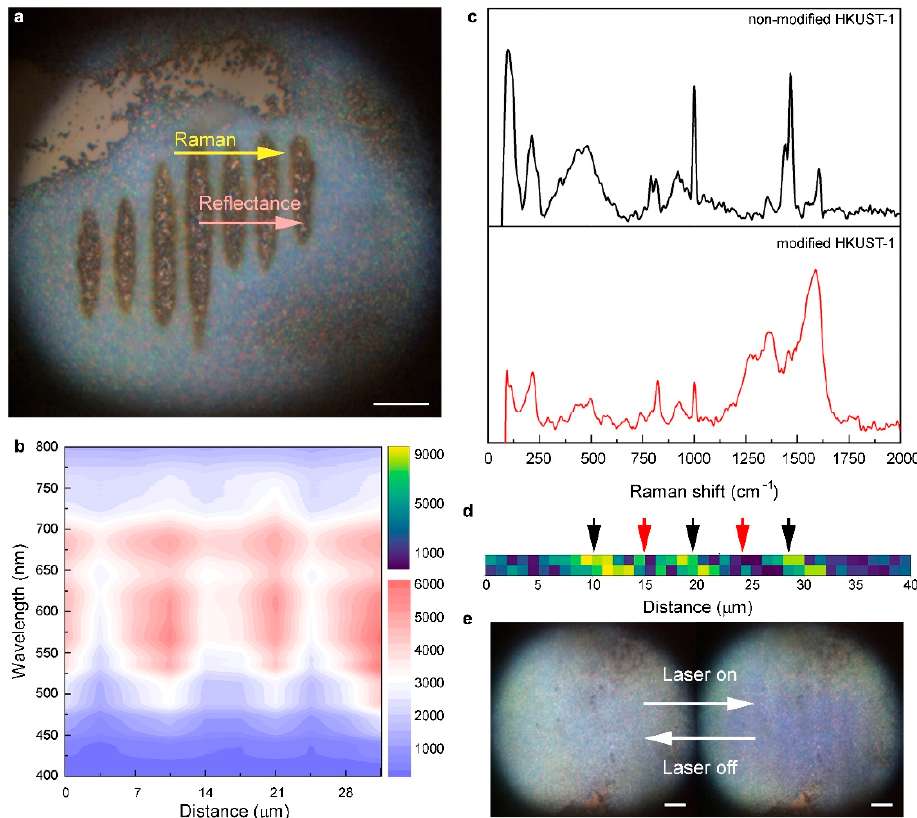
Figure 3. ( a ) Optical image of the irreversible pattern, analyzed by ( b ) optical reflection (pink arrow) and ( c , d ) Raman (yellow arrow) mapping. Scale bar for ( a ), 20 µm. ( c ) The laser interference minima and maxima corresponding to the non-modified area (black curve and black arrows in ( d )) and the modified area (red curve, red arrows in ( d )) of the HKUST-1 thin film. ( d ) Raman mapping of coordination-bonds (the vibrations of Cu-O of the [Cu 2 C 4 O 8 ] cage centered at 180–290 cm − 1 ); black arrows indicate the bond retention, while the red ones correspond to bond breaking. ( e ) Optical images of the reversible mode. Scale bar, 20 µm.